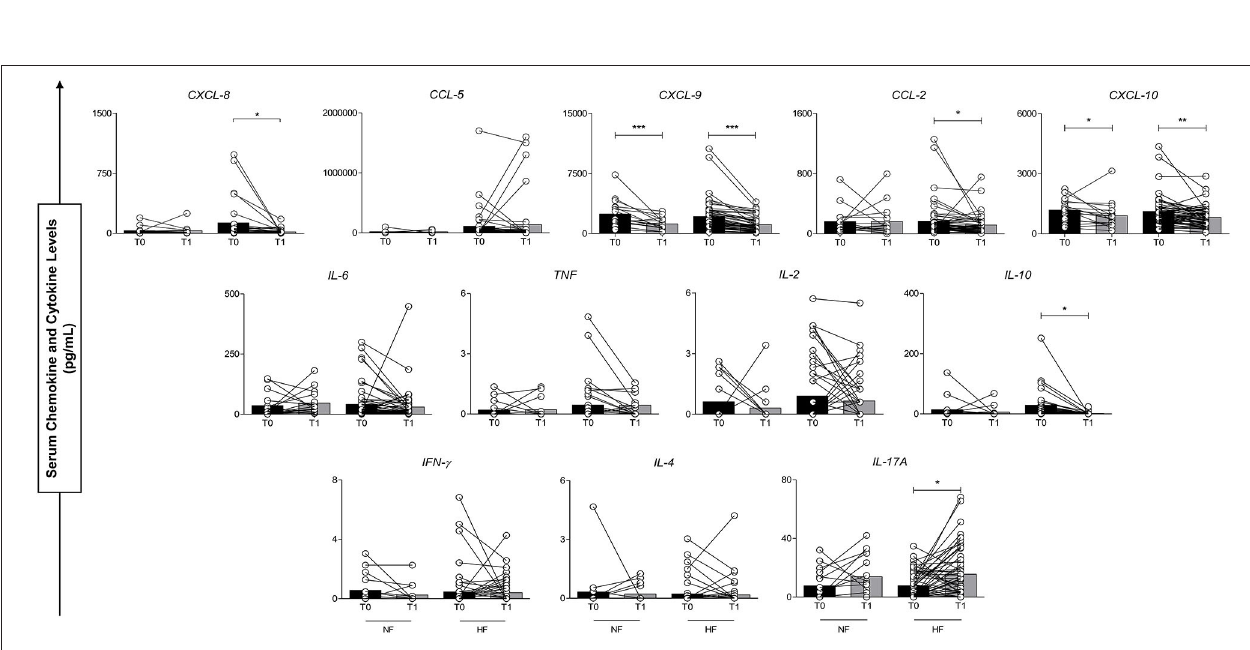
Frontiers in Immunology | www.frontiersin.org